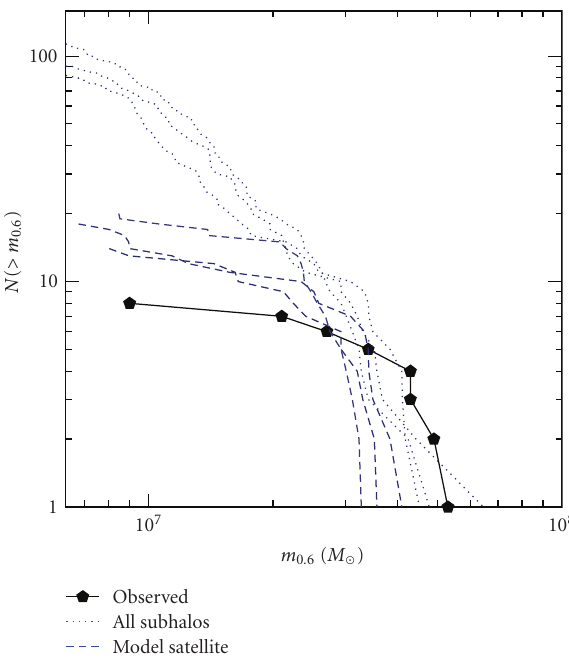
Figure 12: The cumulative m 0 . 6 function of subhalos in the Λ CDM simulations of three MW halos (dotted lines) and for the observed dSph Milky Way satellites (points, connected by solid line) Sagittarius was excluded due to its very large mass errors), as measured by [90]. The dashed lines show the mass function for subhalos with L ≥ 2 . 6 × 10 5 L (cid:4) and d < 270 kpc (the same range of luminosities and distances as for the observed satellites) with luminosities assigned using (4). I have excluded the two most luminous objects from the model luminous satellites to account for the fact that SMC and LMC are not included in the observational sample and one additional object to account for noninclusion of the Sagittarius dwarf in the